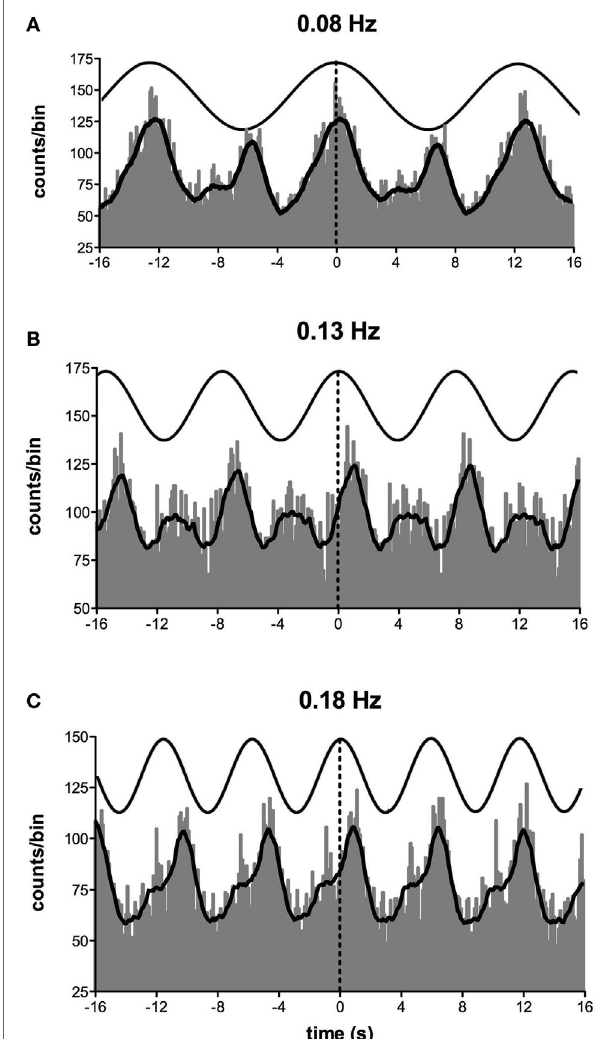
FiGURe 4 | Cross-correlation histograms between muscle sympathetic nerve activity and sinusoidal GVS in one subject. The thick curve superimposed on the histograms is the smoothed polynomial that was fitted to the data. The sinusoid above represents the galvanic stimulus, delivered at (A) 0.08, (B) 0.13, and (C) 0.18 Hz. Each cross-correlation histogram shows a large peak of modulation (primary peak), associated with the positive peak of the sinusoid, and a smaller peak (secondary peak). The secondary peak was largest at 0.08 Hz and smallest at 0.18 Hz. Reproduced with permission from Hammam et al.